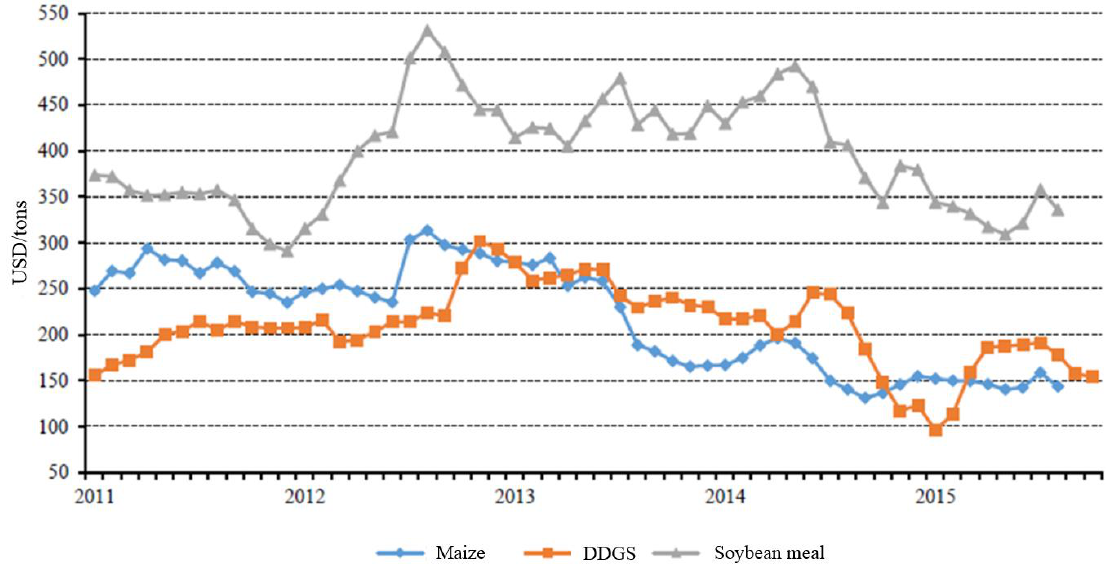
Figure 2. Evolution of maize, distiller’s dried grain with solubles (DDGS), and soybean meal prices. Source: [19].